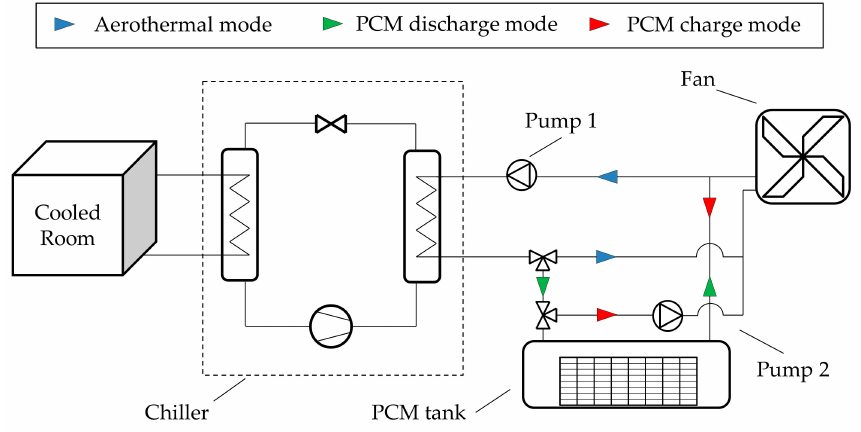
Figure 1. Schematic diagram of the chiller-phase change materials (PCM) system.